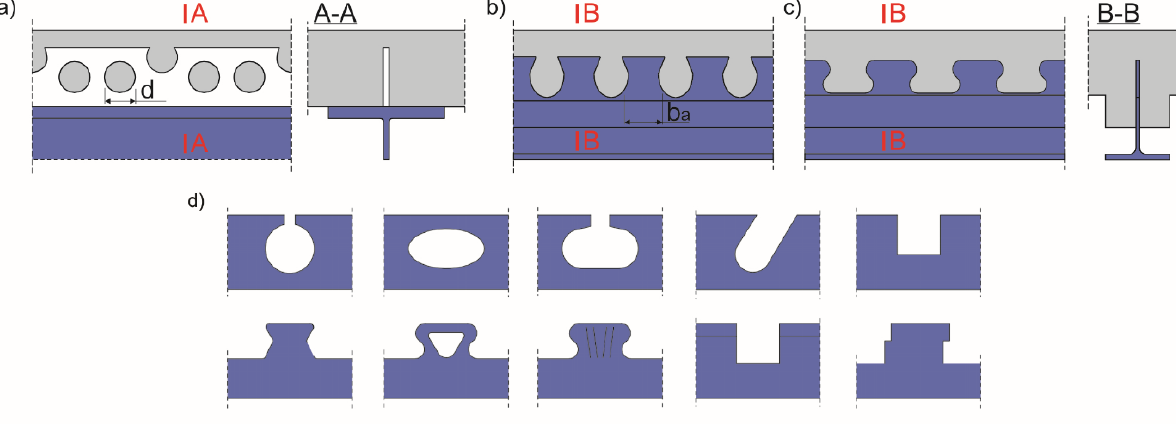
Figure 2: Continuous shear connectors [13]: a) Perfobond, b) kombi, and c) composite dowels using puzzle shapes that have been tested in the context of [7] project and d) additional shapes of shear connectors studied by different researchers [44].